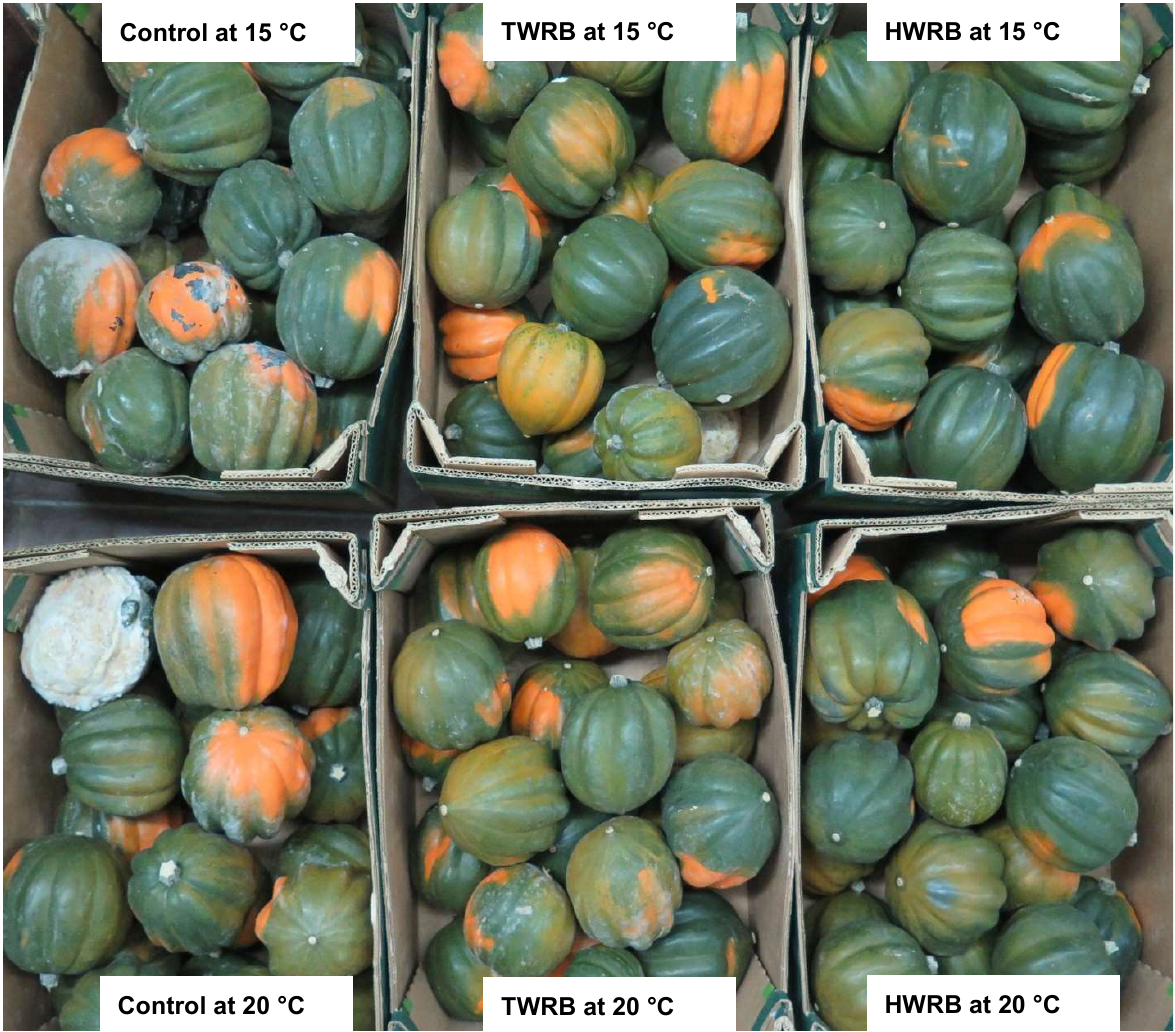
Figure 1. The influence of storage temperature and water treatment on Acorn squash quality after 3.5 month at 15 or 20 °C plus 3 days at 20 °C (TWRB = tap water rinsing and brushing; HWRB = hot water rinsing and brushing at 54 ± 1 °C for 15 s).